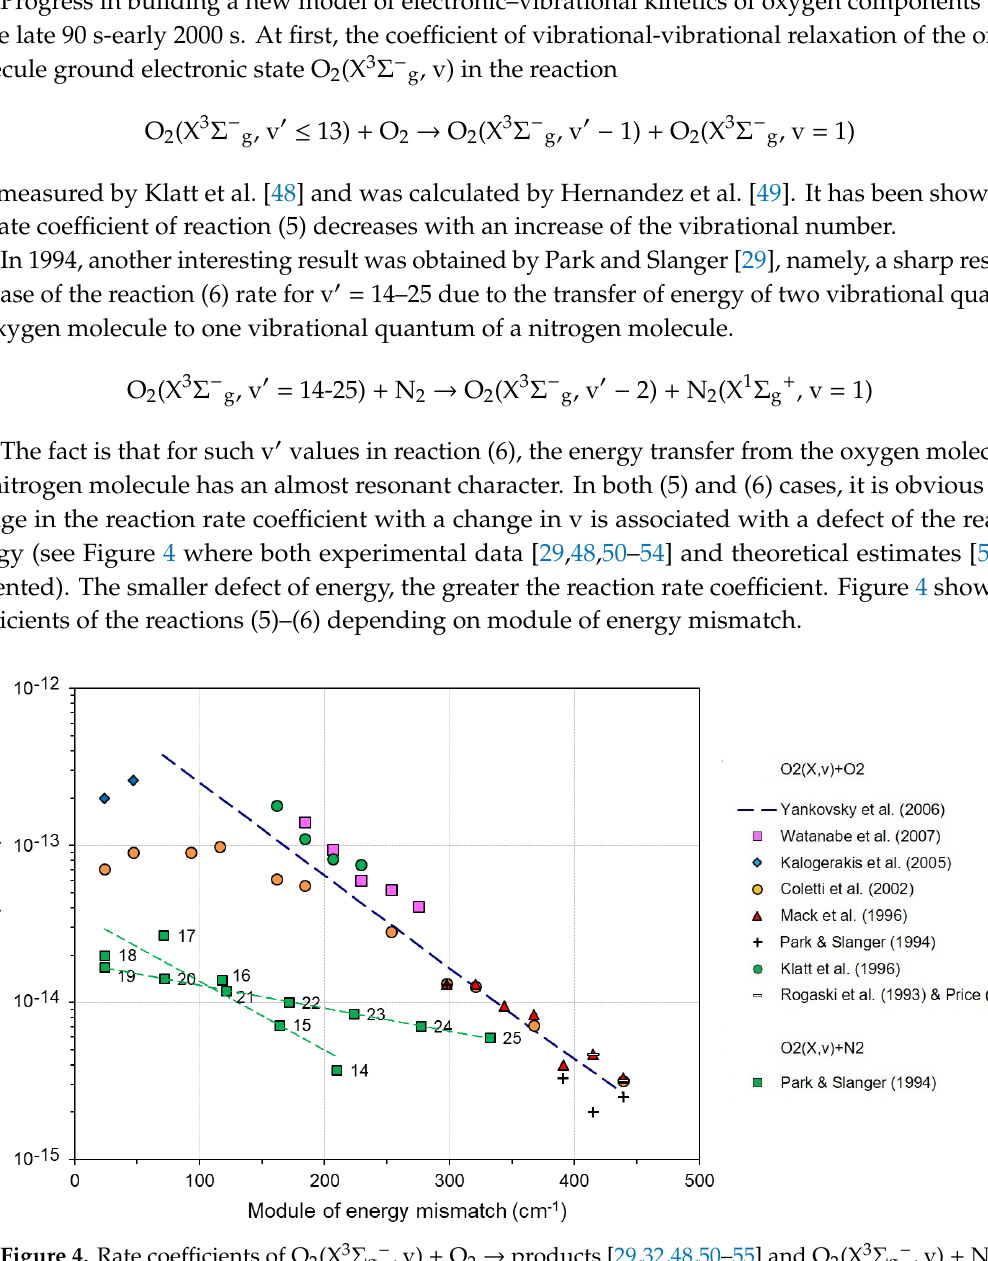
Figure 4. Rate coe ffi cients of O 2 (X 3 Σ g − , v) + O 2 → products [29,32,48,50–55] and O 2 (X 3 Σ g − , v) + N 2 → products [29] depending on module of energy mismatch. The numbers indicate values of the vibrational quantum.